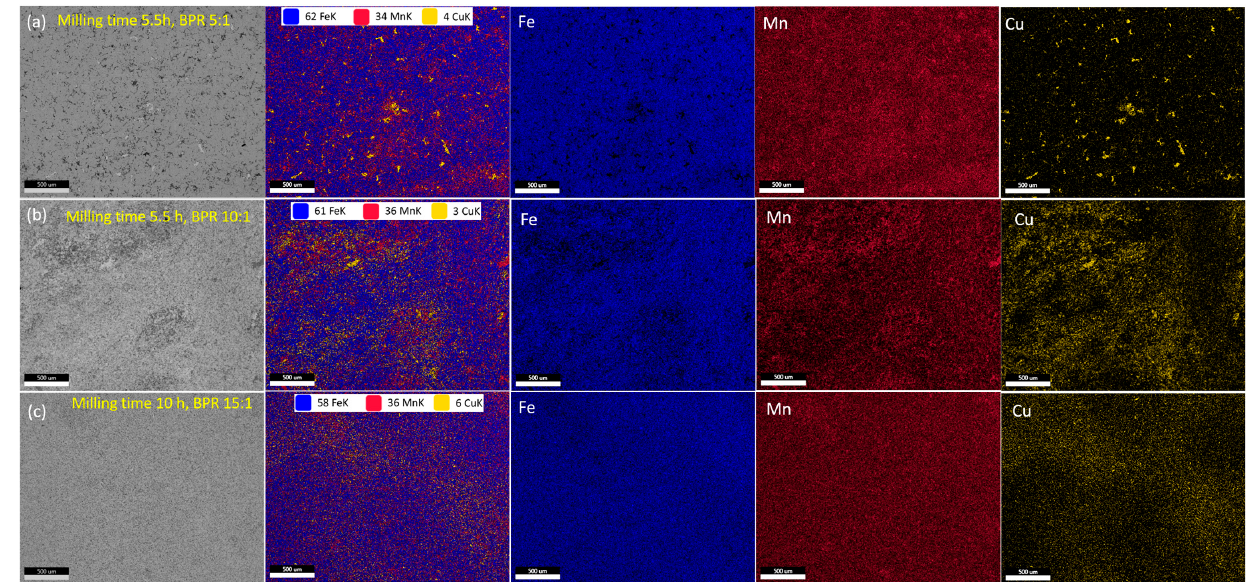
Figure 6. FE-SEM live and elemental mapping of FeMn 30 Cu 5 hot-forged biodegradable alloys processed at different milling conditions: ( a ) 5.5 h with BPR 5:1; ( b ) 5.5 h with BPR 10:1; ( c ) 10 h with BPR 15:1. First column represents the HR-SEM microstructures; second column represents the elemental overlay map; third, fourth, and fifth columns represent the elemental map of Fe, Mn, and Cu, respectively .